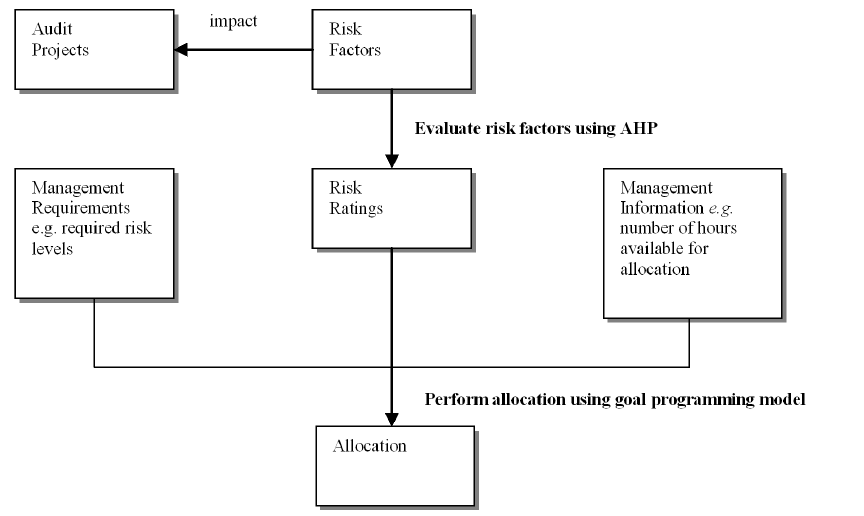
Figure 1: Risk and resource allocation